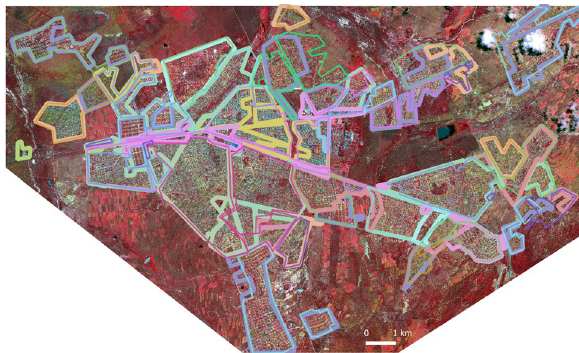
Figure 2: Zoning pre and post ground truth: Initial zoning pre ground truth considered eleven narrow zones indicated by thick- er lines, while the zoning post ground truth contains eight broader zones shown by thinner